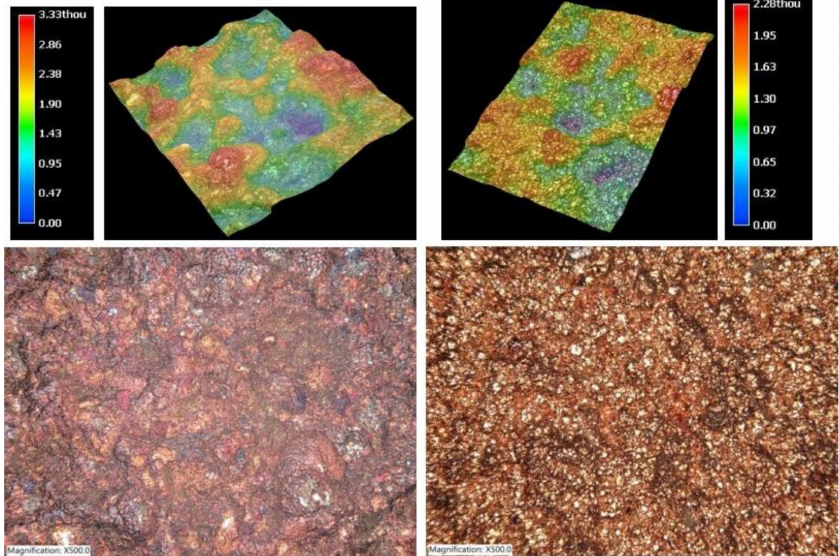
Figure 28. Confocal microscopy analysis of nanostructured Cu and conventional Cu cold spray coatings. The top-left and bottom-left micrographs concern the nanostructured coating. The top-right and bottom-right micrograph and surface rendering are concerned with the conventional